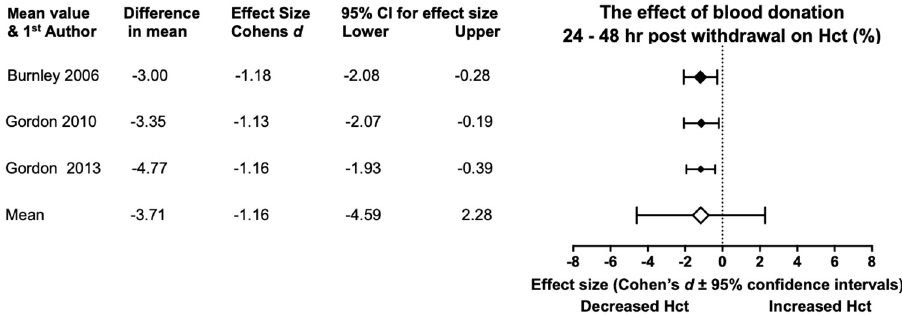
Fig 6. Statistical results from three studies of pre and 24–48 hr post BD in Hct. With the diamonds reflecting the effect size of the studies. The white diamond shows the overall mean effect size. All effect sizes are Cohen’s d and 95% confidence interval, with heterogeneity of I 2 =